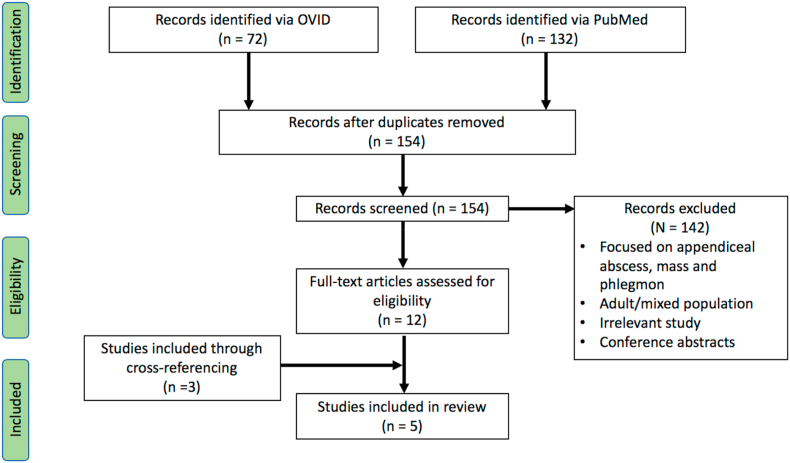
PRISMA flow diagram.